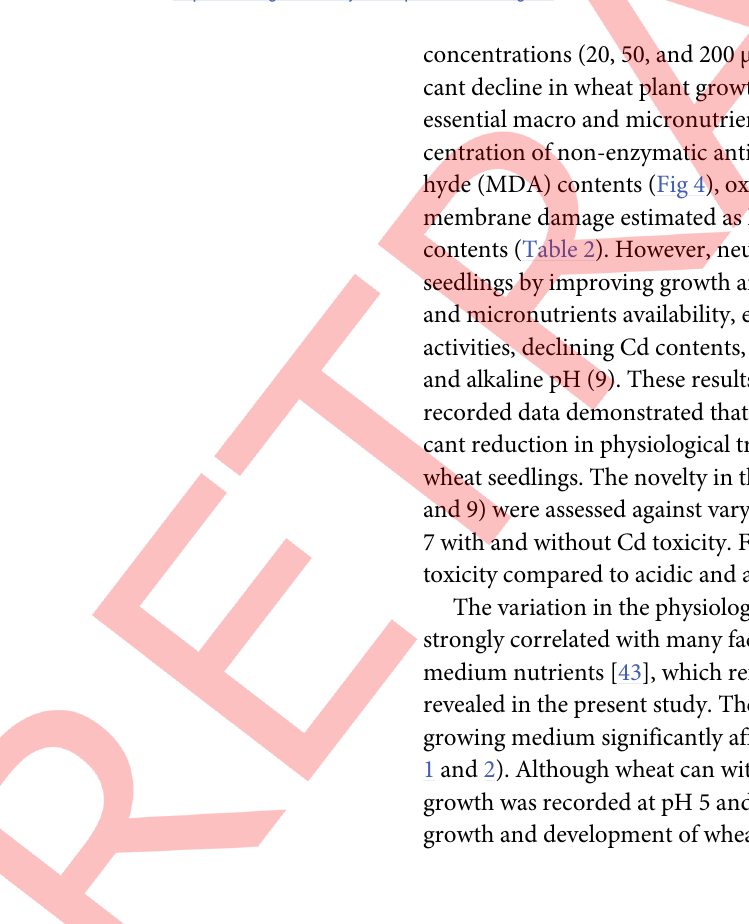
Fig 5. Correlation between the concentration of available Cd in the shoot (Cd-S) and root (Cd-R) and pH.